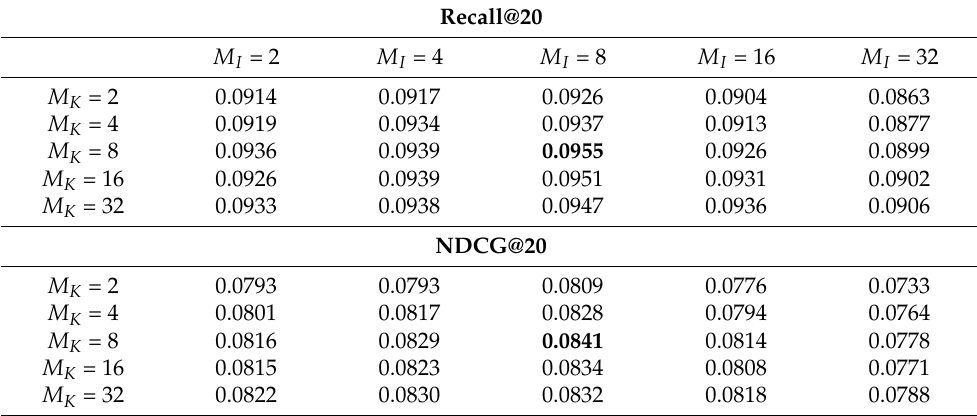
Table 6. Impact of the neighbor number for